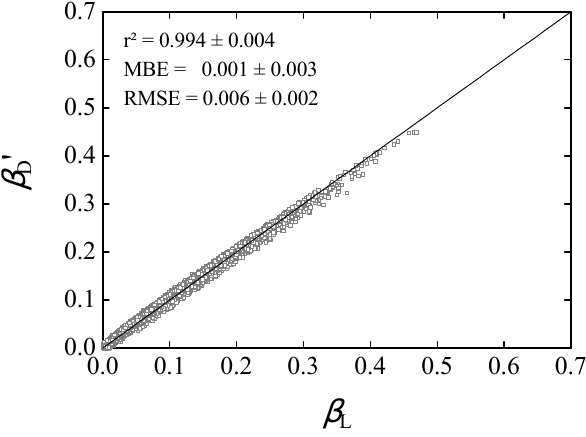
Fig. 5. Comparison between hourly turbidity estimates by using Dogniaux’s correlation modified by Eq. (22) and Louche’s algo-